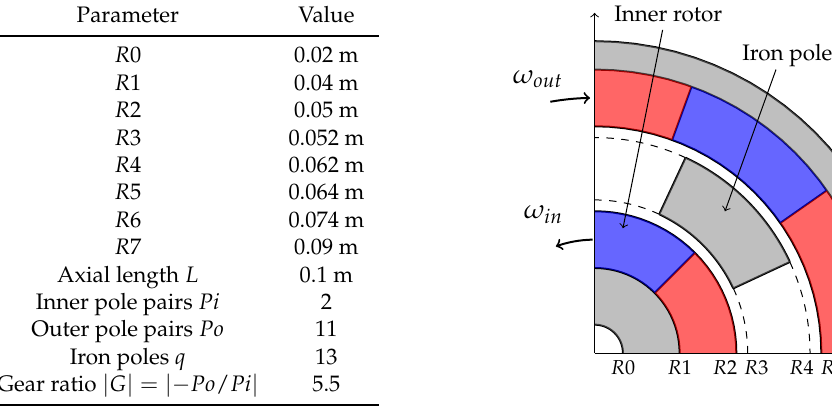
Figure 1. Magnetic gear structure and list of parameters